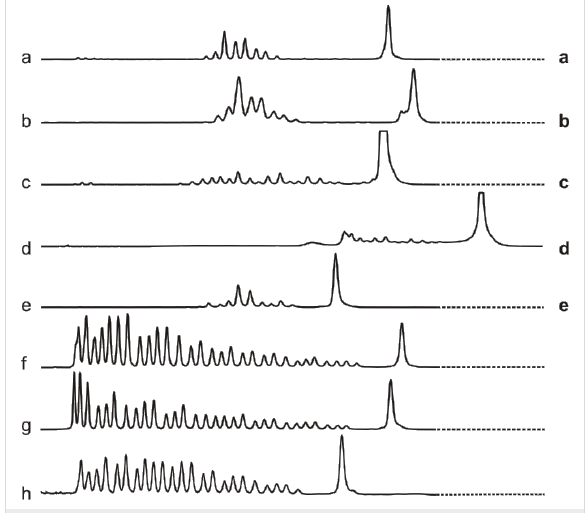
Figure 2: Cleavage of RNA by their corresponding PNA conjugates (150 nM substrate, 750 nM conjugate, 50 mM Tris-HCl, pH 8, 37 °C, 20 h). Lane a: conjugate 10 and substrate 15 . Lane b: conjugate 12 and substrate 15 . Lane c: conjugate 11 and substrate 16 . Lane d: conjugate 13 and substrate 16 . Lane e: conjugate 14 and substrate 17 . Lanes f, g and h: hydrolysis patterns of 15 , 16 and 17 (Na 2 CO 3